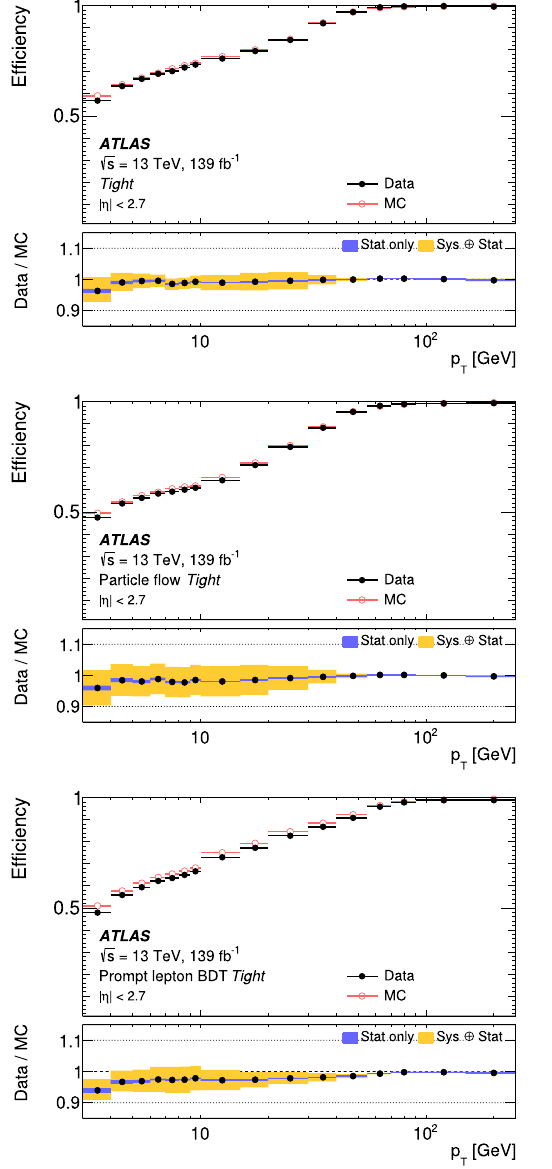
efficiency measurement is smaller than the size of the markers, and thus not displayed. The panel at the bottom shows the ratio of the measured to predicted efficiencies, with statistical and systematic